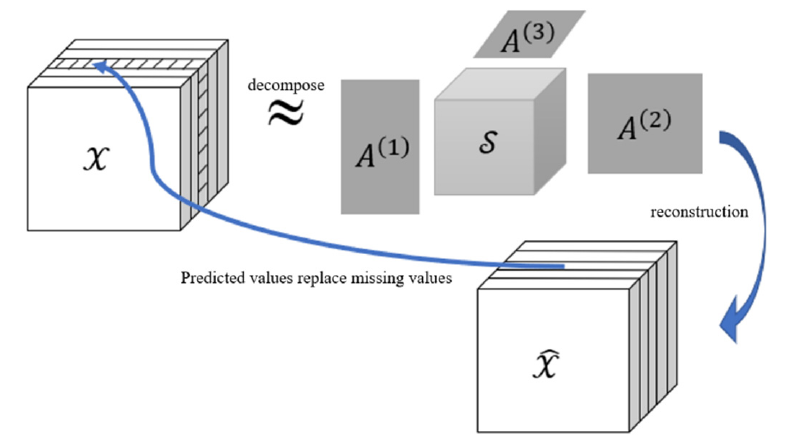
Figure 3. Tensor decomposition and reconstruction. Figure 3. Sparse tensor